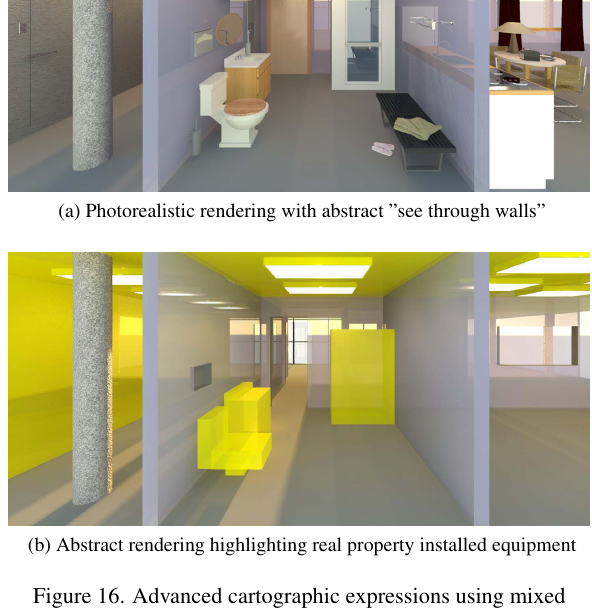
Figure 16. Advanced cartographic expressions using mixed LODs. Data courtesy of Autodesk, RevitCity, Tork, and